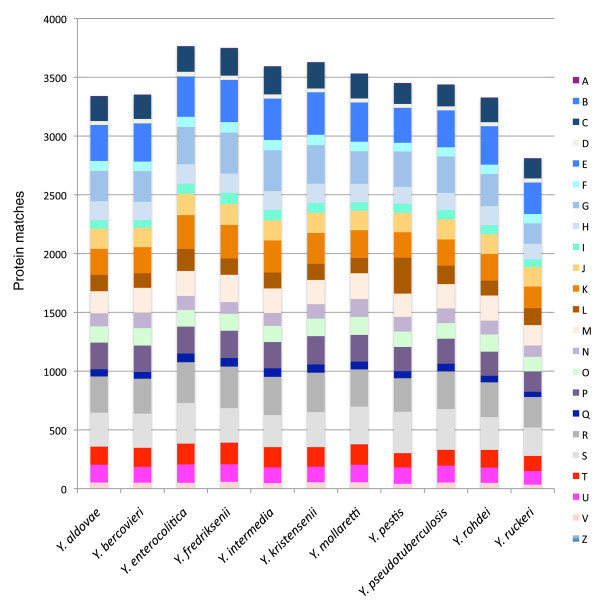
Comparison of major COG groups in Yersinia genomes. Bars represent the number of proteins assigned to COG superfamilies [52] for each genome, based on matches to the Conserved Domain Database [95] database with an E-value threshold <10-10. The COG groups are: U, intracellular trafficking; G, carbohydrate transport and metabolism; R, general function prediction; I, lipid transport and metabolism; D, cell cycle control; H, coenzyme transport and metabolism; B, chromatin structure; P, inorganic ion transport and metabolism; W, extracellular structures; O, post-translational modification; J, translation; A, RNA processing and editing; L, replication, recombination and repair; C, energy production; M, cell wall/membrane biogenesis; Q, secondary metabolite biosynthesis; Z, cytoskeleton; V, defense mechanisms; E, amino acid transport and metabolism; K, transcription; N, cell motility; T, signal transduction; F, nucleotide transport; S, function unknown.